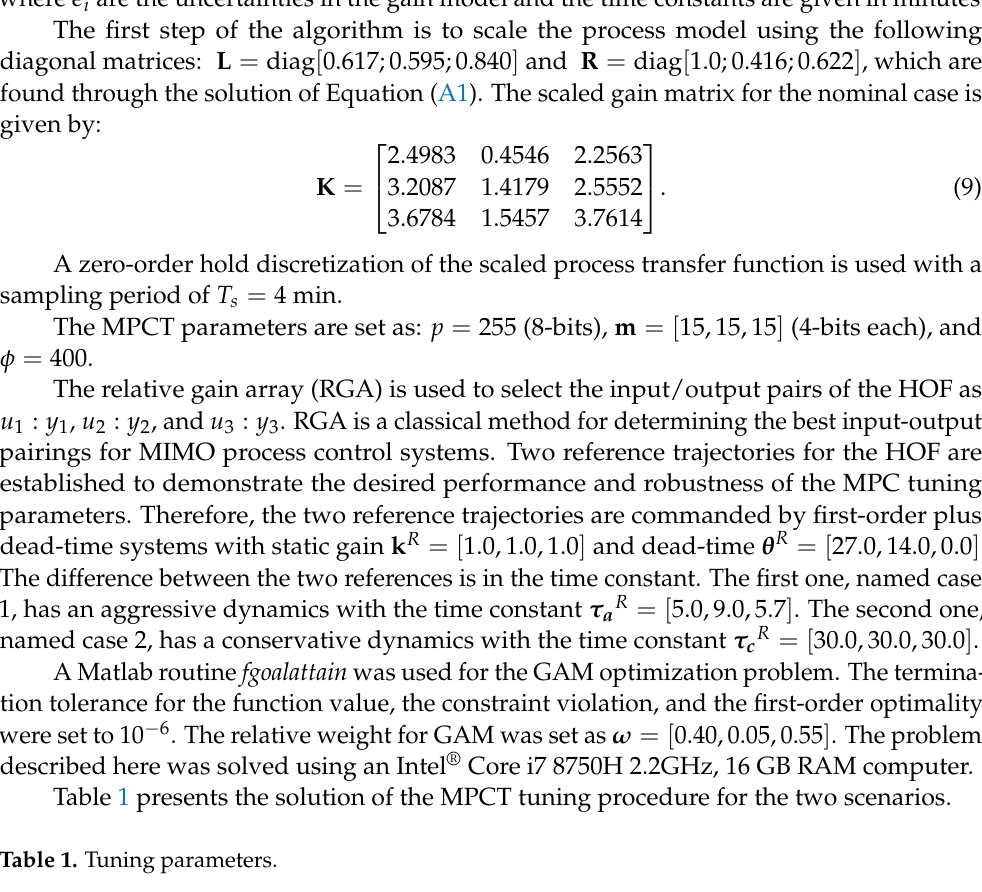
Table 1. Tuning parameters. MPCT Scenario x dv case